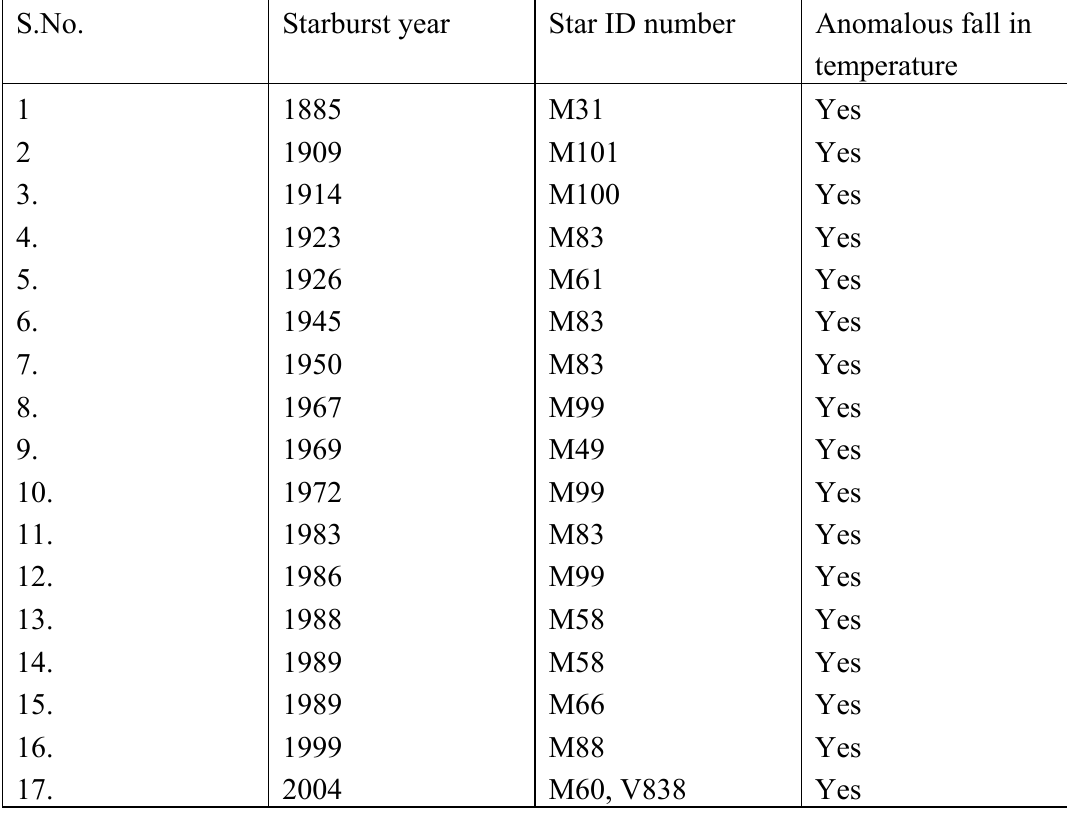
Table 2. Starbursts lower the temperature of earth. Forbursh effect lowers the E-flux from Sun followed by a fall in atmospheric temperature. Source: NCDC USA and Messier catalog.